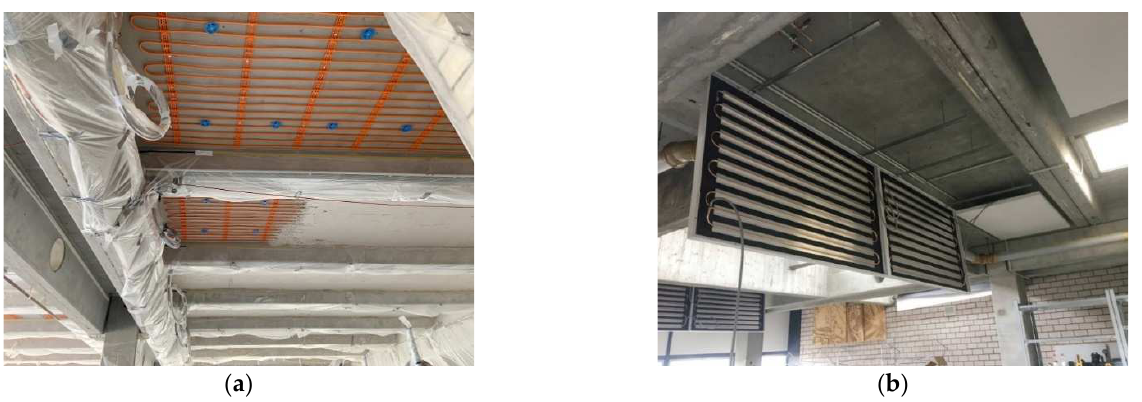
Figure 3. Mounting the plastered heating meander ( a ) and the suspended heating panel ( b ).